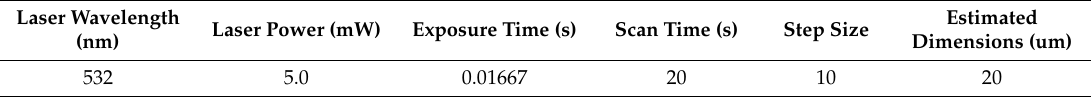
Table 2. Micro-Raman spectroscopy parameters.